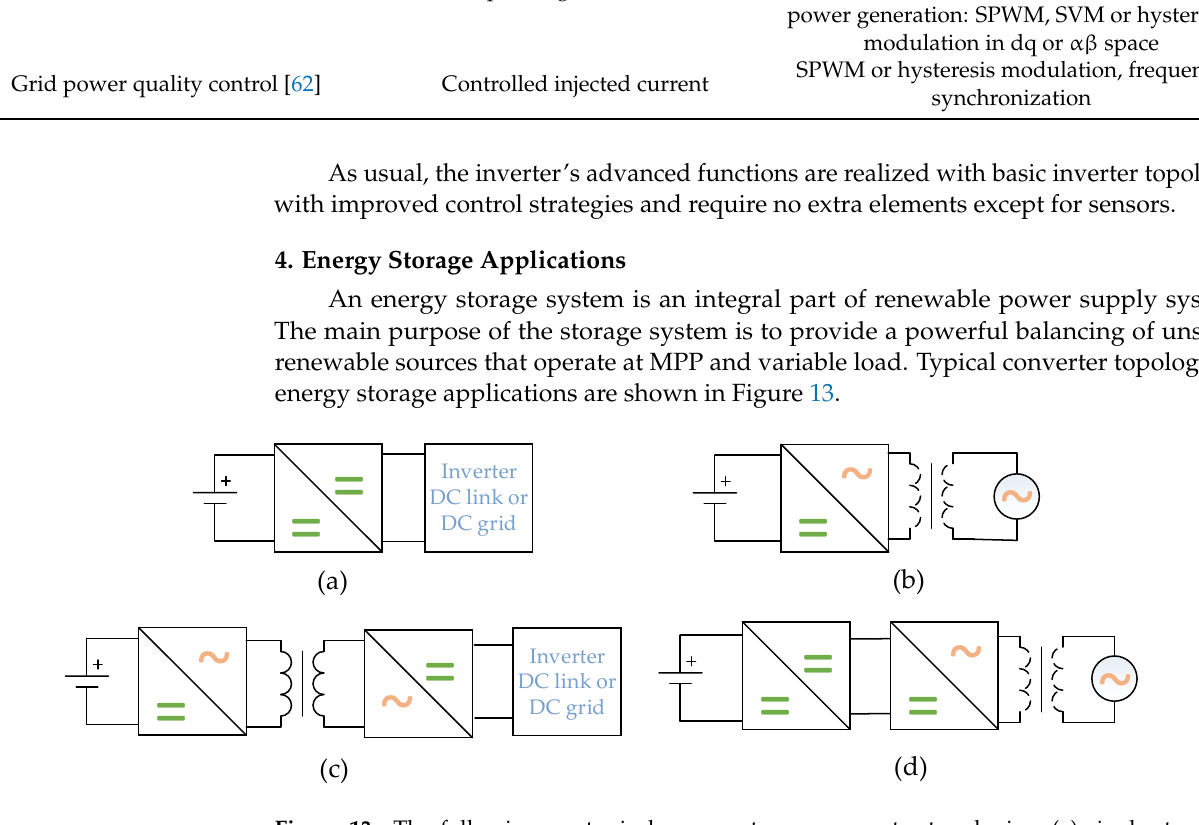
Table 5. List of additional converter functions.